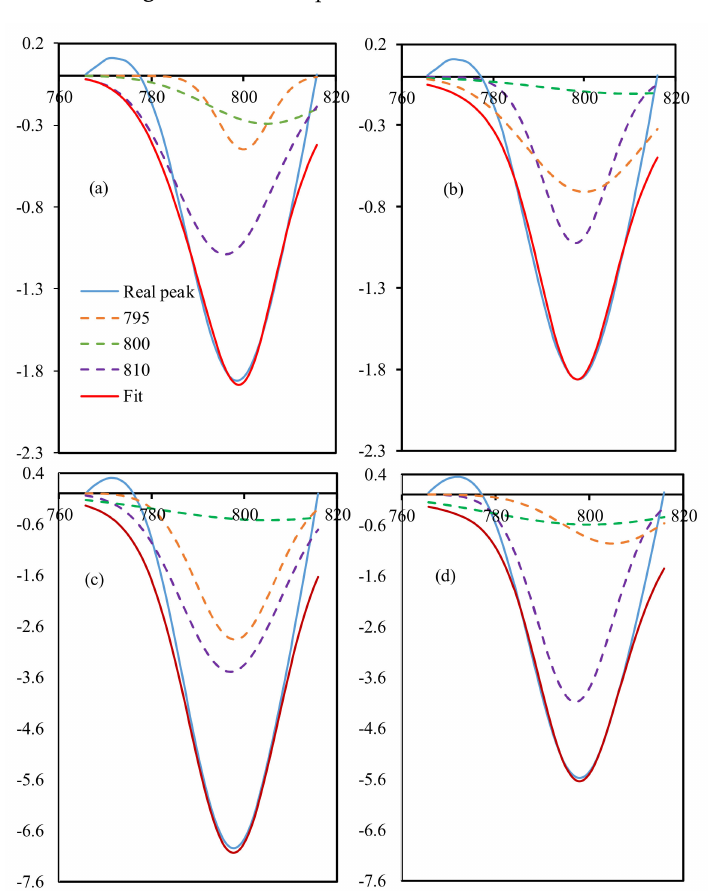
Figure 7. FTIR deconvolution of peak 800 cm − 1